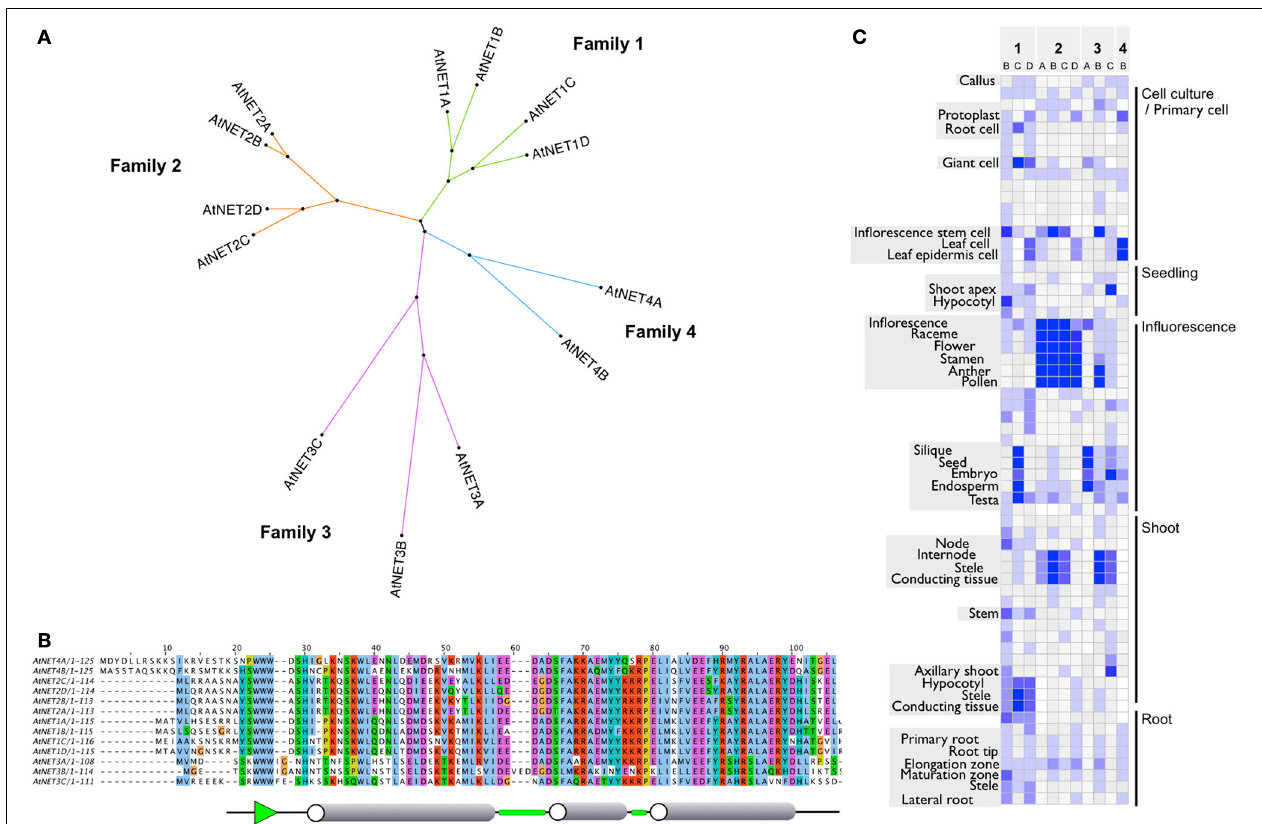
FIGURE 1 | (A) Radial cladogram of the Arabidopsis NET protein superfamily. Protein sequences fall into four distinct clades or families. (B) NAB domain protein sequence alignment. ClustalX default residue coloring scheme based on physiochemical properties. Consensus secondary structure is shown